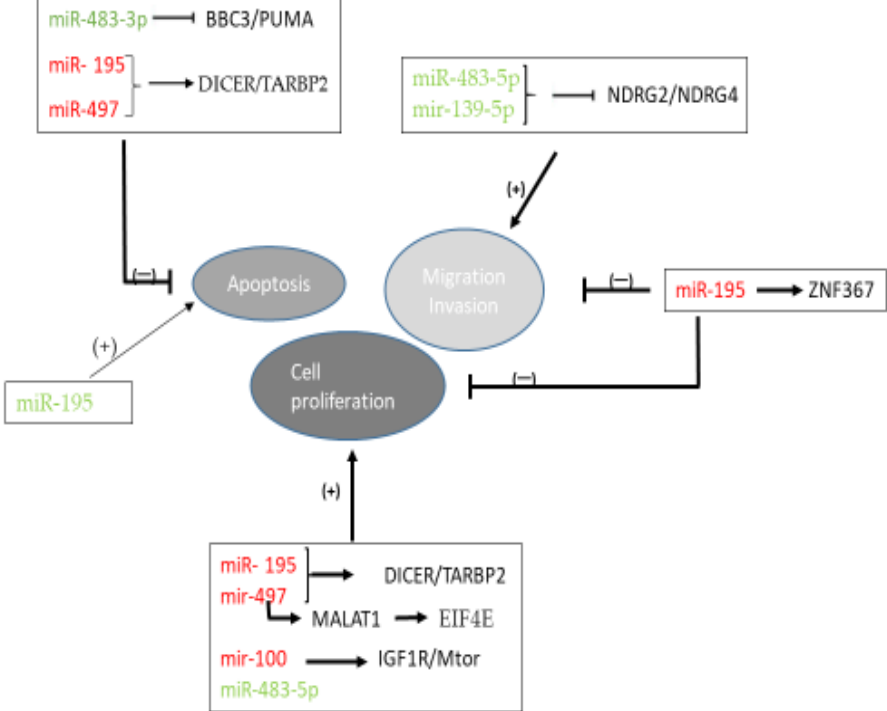
Figure 2. Schematic representation showing the miRNA- mediated mechanisms involved in ACC pathogenesis. Green fonts indicate upregulation and red fonts indicate downregulation of miRNAs. Arrows indicate stimulation, whereas T-arrows indicate inhibition. Abbreviations: BBC3; Bcl-2- binding component 3, EIF4E; eukaryotic translation initiation factor 4E, IGF1R; insulin-like growth factor 1 receptor; MALAT1; metastasis-associated lung adenocarcinoma transcript 1, miR: microRNA; mTOR: mammalian target of rapamycin; NDRG; N-myc downstream-regulated gene family member, PUMA; p53 upregulated modulator of apoptosis, TARBP2; transactivation response RNA-binding protein 2, ZNF367; zinc finger protein 367.